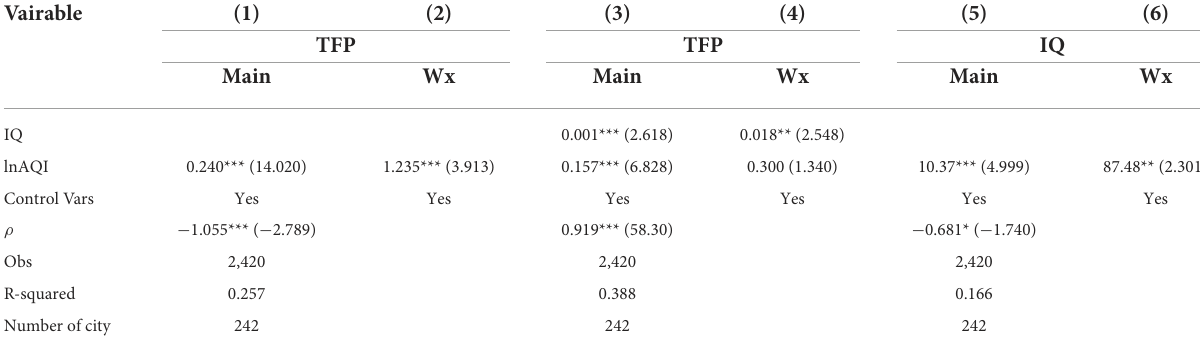
TABLE 13 Thet estimation results of mediating variable—enterprise innovation quality. Vairable